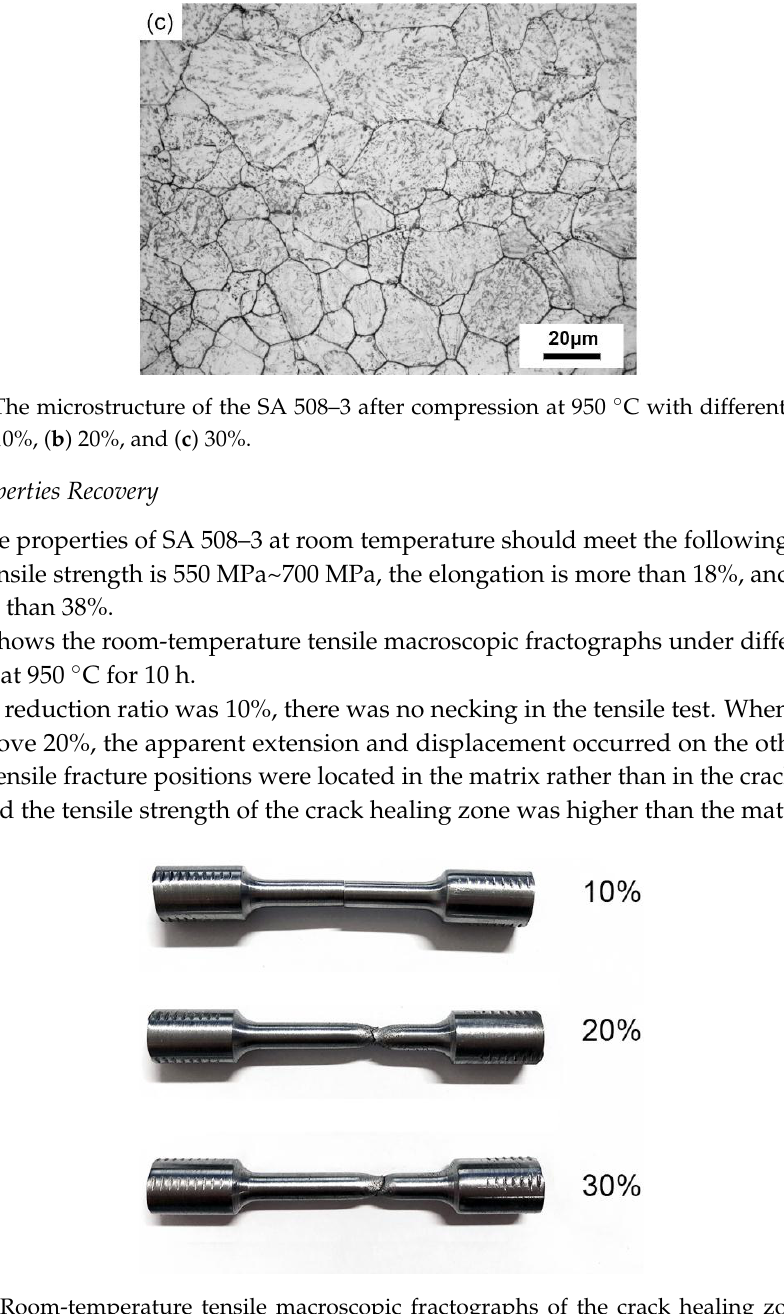
Figure 8. Room-temperature tensile macroscopic fractographs of the crack healing zones under different reduction ratios, healing at 950 °C for 10 h.